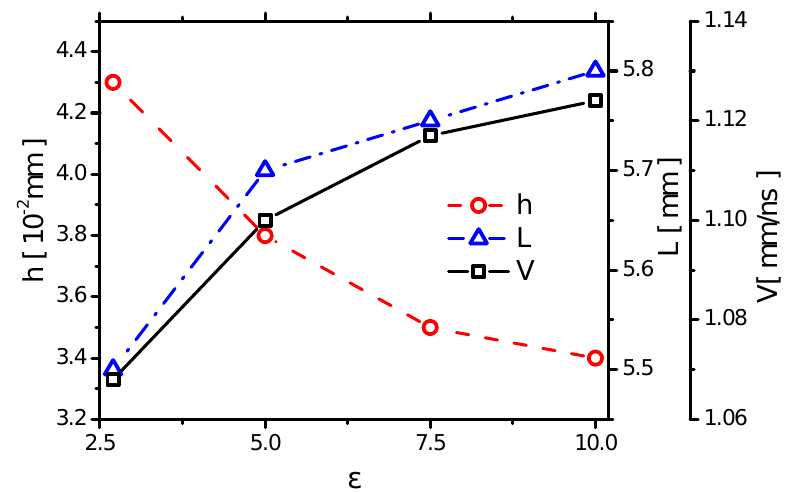
Figure 16. The effects of ε on the streamer propagation speed V , the plasma sheath thickness h , and the maximum streamer length L in Case 1 to Case 4.